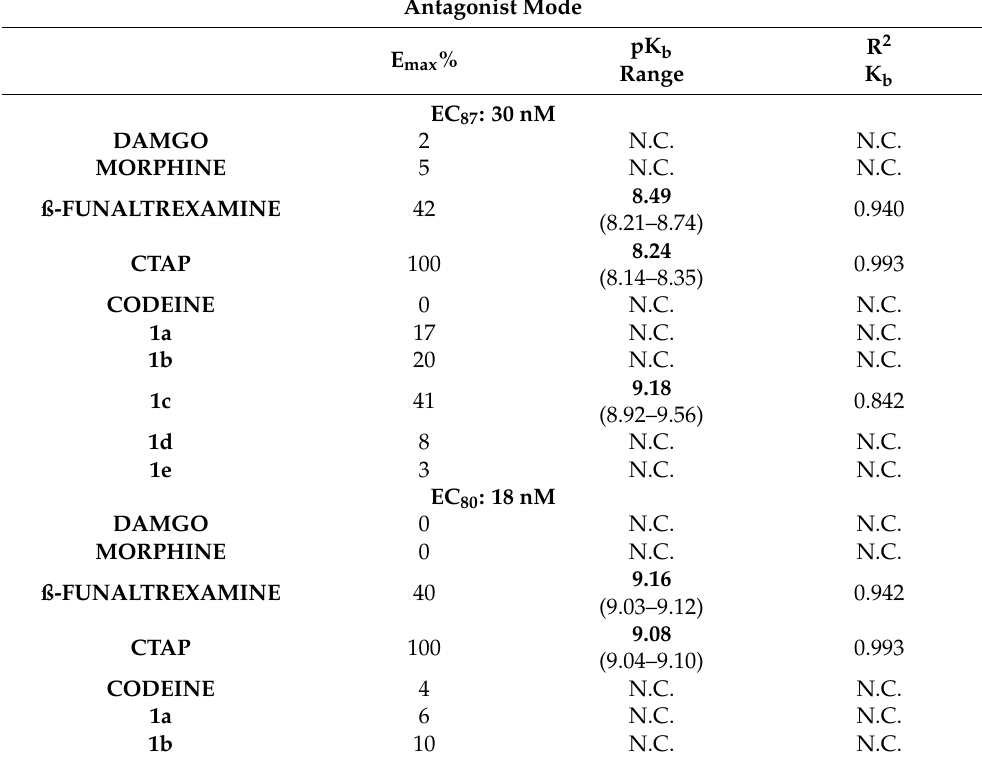
Table 4. Effect of the tested compound on the level of cAMP in CHO-K1 cells with a stable expression of the MOP in the antagonist mode with different concentrations of DAMGO. Functional data from the cAMP assay in the antagonist mode with preincubation of the tested compounds with